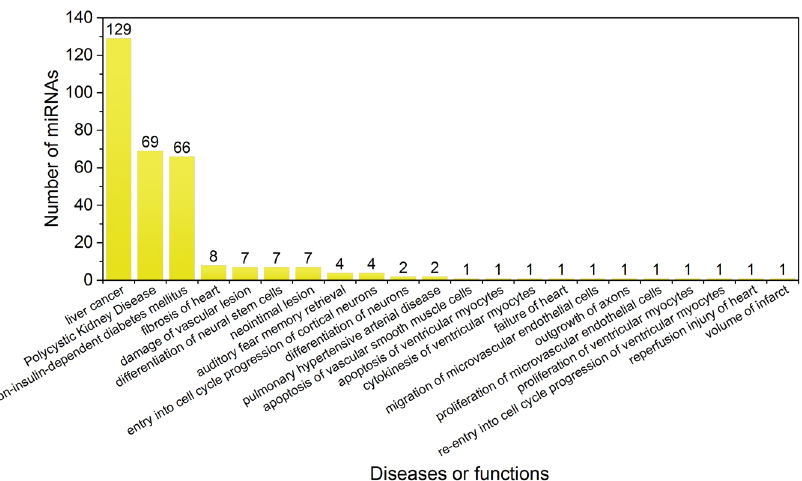
Figure 2. Disease enrichment analysis of DEMs. The liver cancer is predicted as highly significantly enriched with the maximum number of DEMs during disease/function overrepresentation analysis using IPA software. The x-axis depicts diseases/functions, whereas, the y-axis represents the number of DEMs mapped to diseases or